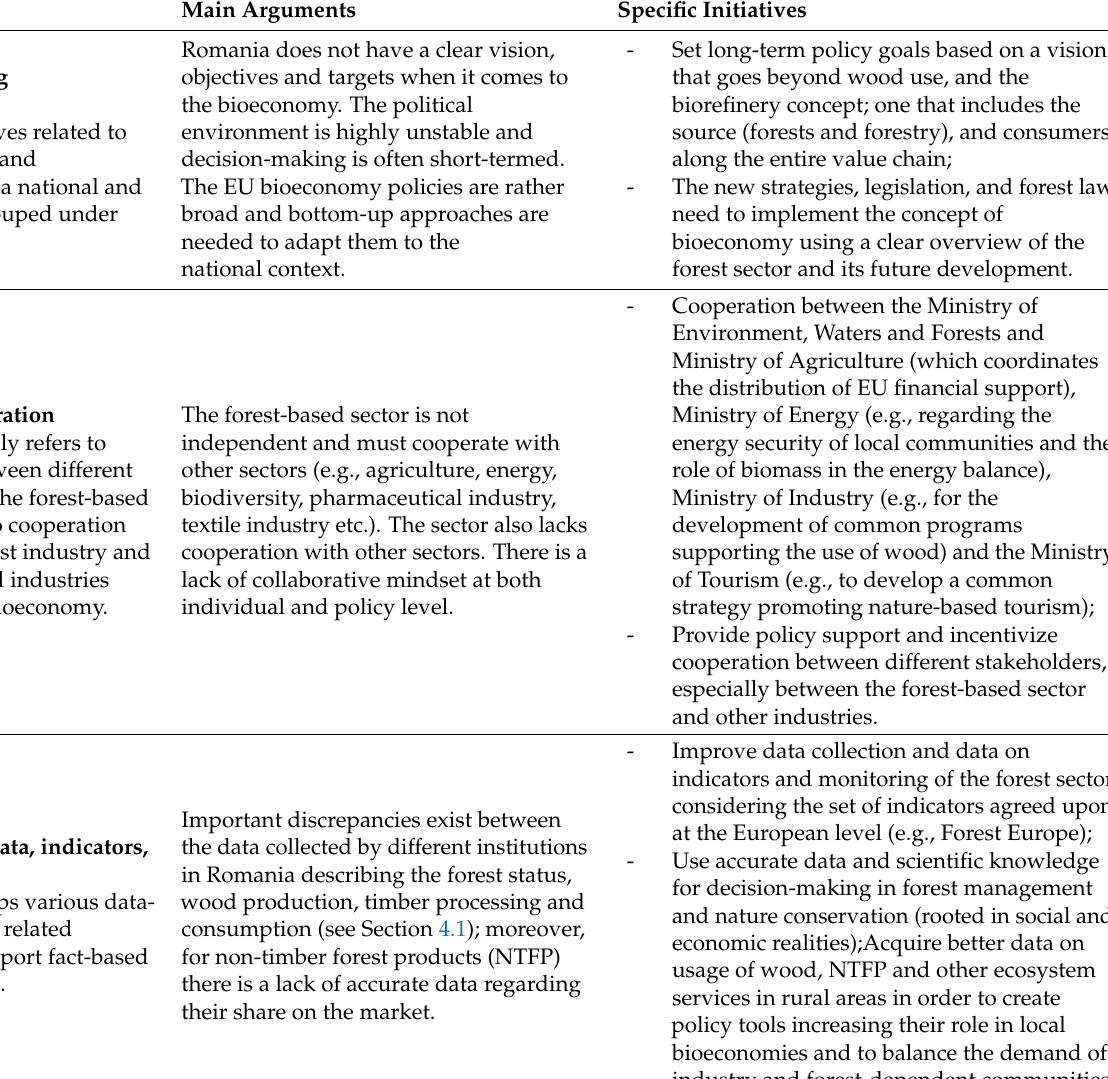
Table 2. Different initiatives suggested by workshop